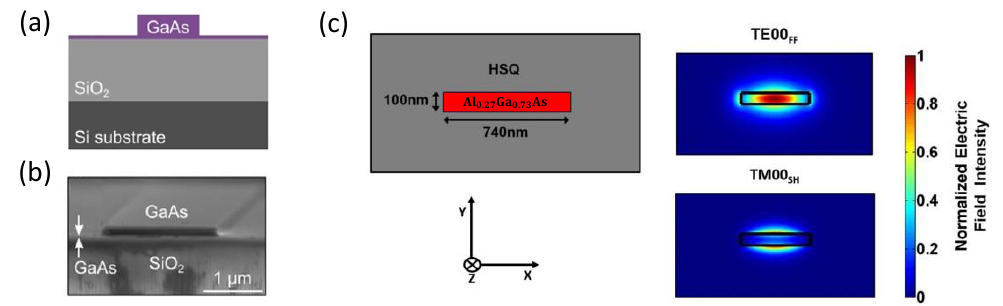
Figure 7. ( a ) Schematic of a GaAs-OI waveguide cross-section. ( b ) SEM image of the waveguide. Reprinted with permission from [10] ©The Optical Society. ( c ) The cross-sectional view of an AlGaAs- OI waveguide and the mode profiles of the fundamental and SH frequencies (with orthogonal polarizations) fulfilling MPM. Reprinted with permission from [11] ©The Optical